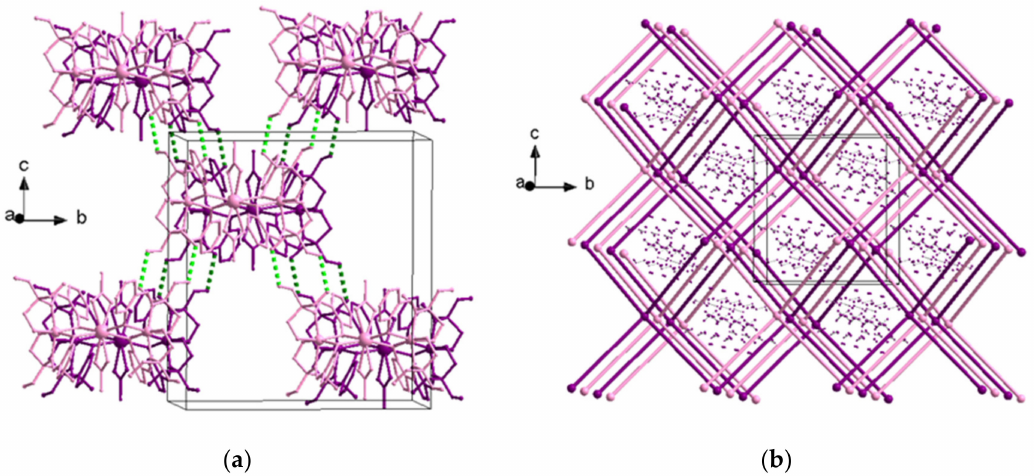
Figure 2. ( a ) The two 4-connected nodes of trinuclear clusters in 4 . The clusters / nodes creating one of the two interpenetrating lattices are indicated in pink color and the corresponding hydrogen bonds are shown as light green dashed lines. Those of the second lattice are indicated with violet color and the corresponding hydrogen bonds with dark green dashed lines. ( b ) A small part of the 3D supramolecular network of 4 using only the nodes in the representation consisting of two interpenetrating diamondlike lattices, indicated with pink and violet colors. In the channels formed along a -axis the counteranion and the solvent molecules are